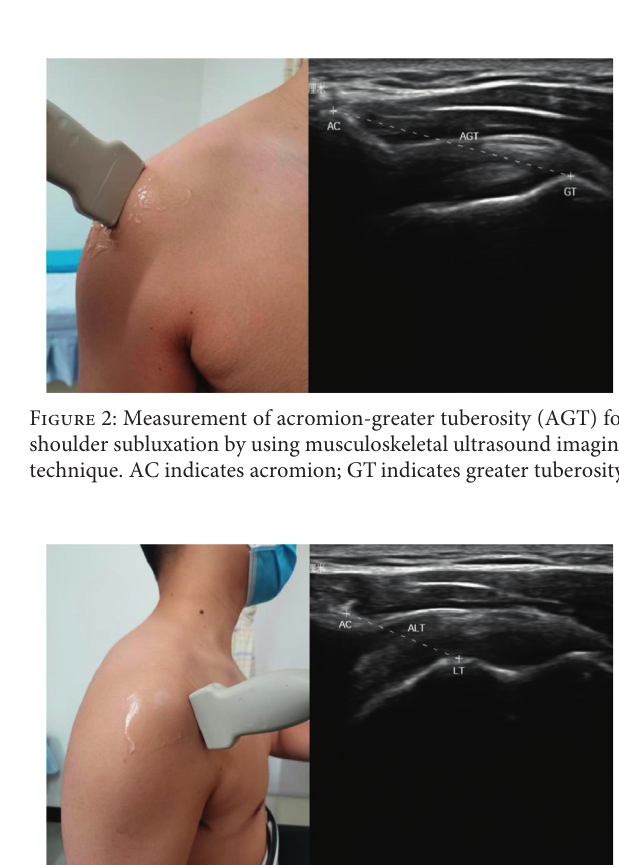
Figure 1: Measurement of acromiohumeral distance (AHD) for shoulder subluxation by using musculoskeletal ultrasound imaging technique. AC indicates acromion; HH indicates humerus head.